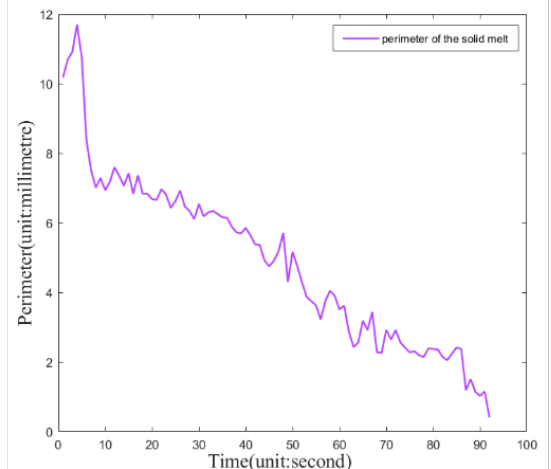
Figure 8. Silicon dioxide during melting in a hot cell change in circumference at each moment.